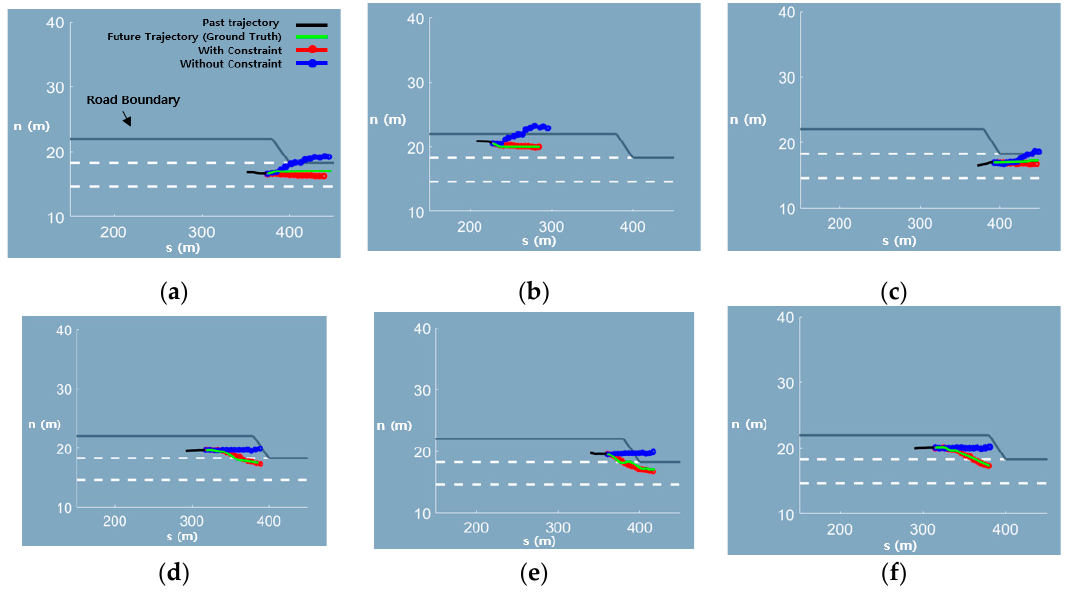
Figure 10. Comparison of the trajectories predicted by the trajectory prediction network with (red line) and without (blue line) constraint. ( a – c ) show that the trajectory prediction network without constraint predict LCL as the most probable maneuver despite the road boundary on the left side of the car. ( d – f ) show that the prediction network without constraint predict LK as the most probable maneuver despite its proximity to the end of merging section while the trajectory prediction network with constraint predict LCR.